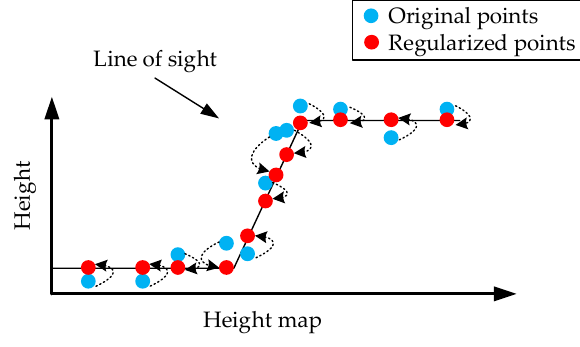
Figure 12. The regularization process of the points in the height map.